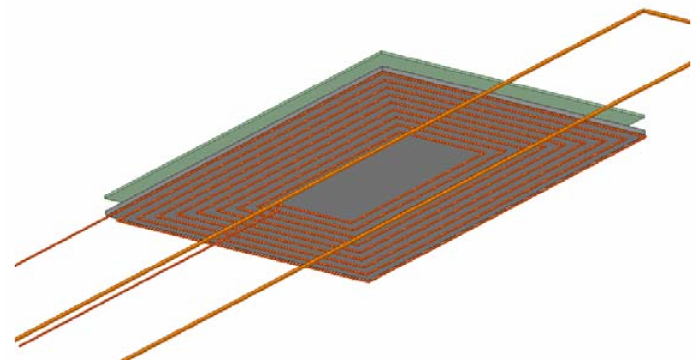
Figure 12. Finite element simulation model of